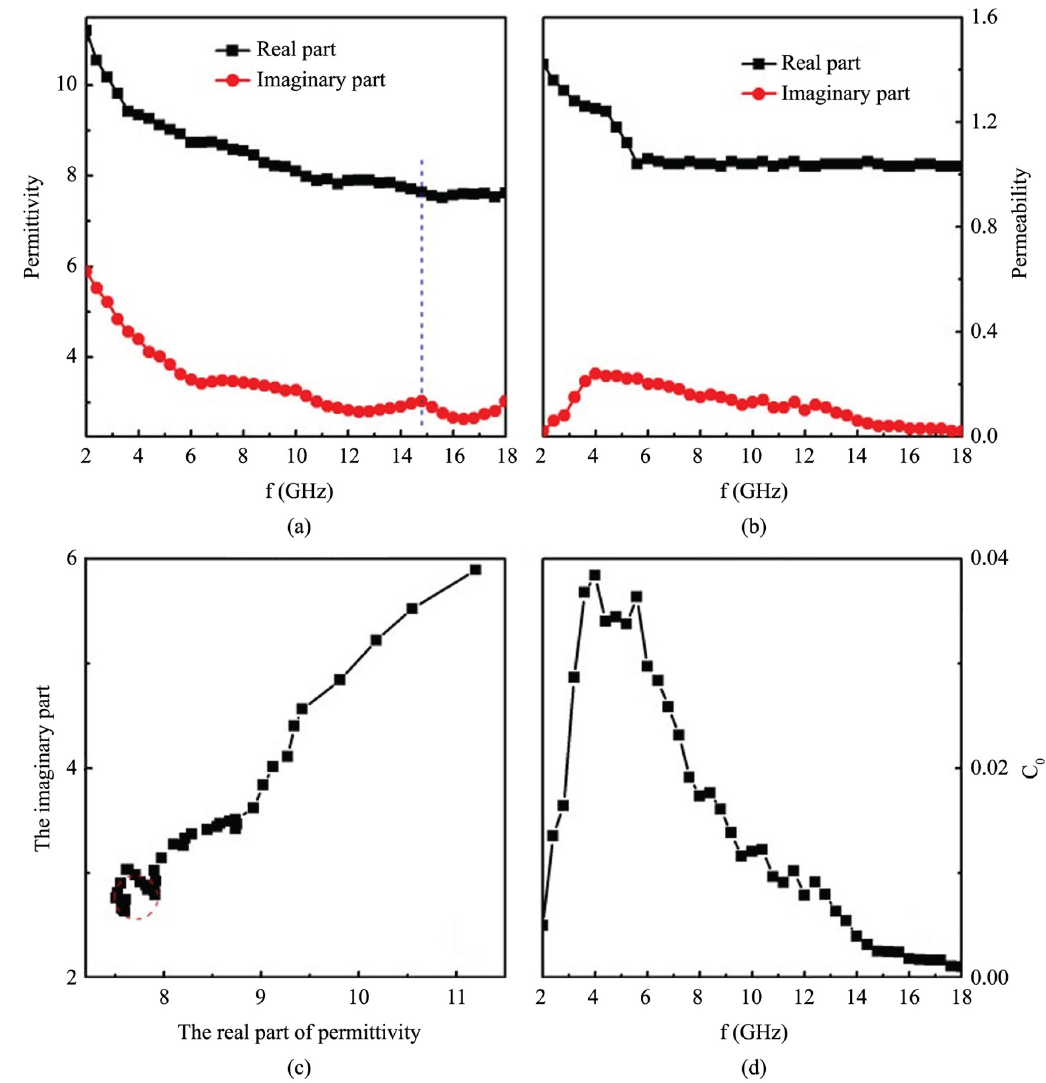
Figure 3. Frequency dependence of (a) the relative complex permittivity and (b) the relative complex permeability, (c) Cole-Cole plot, and (d) frequency dependence of C